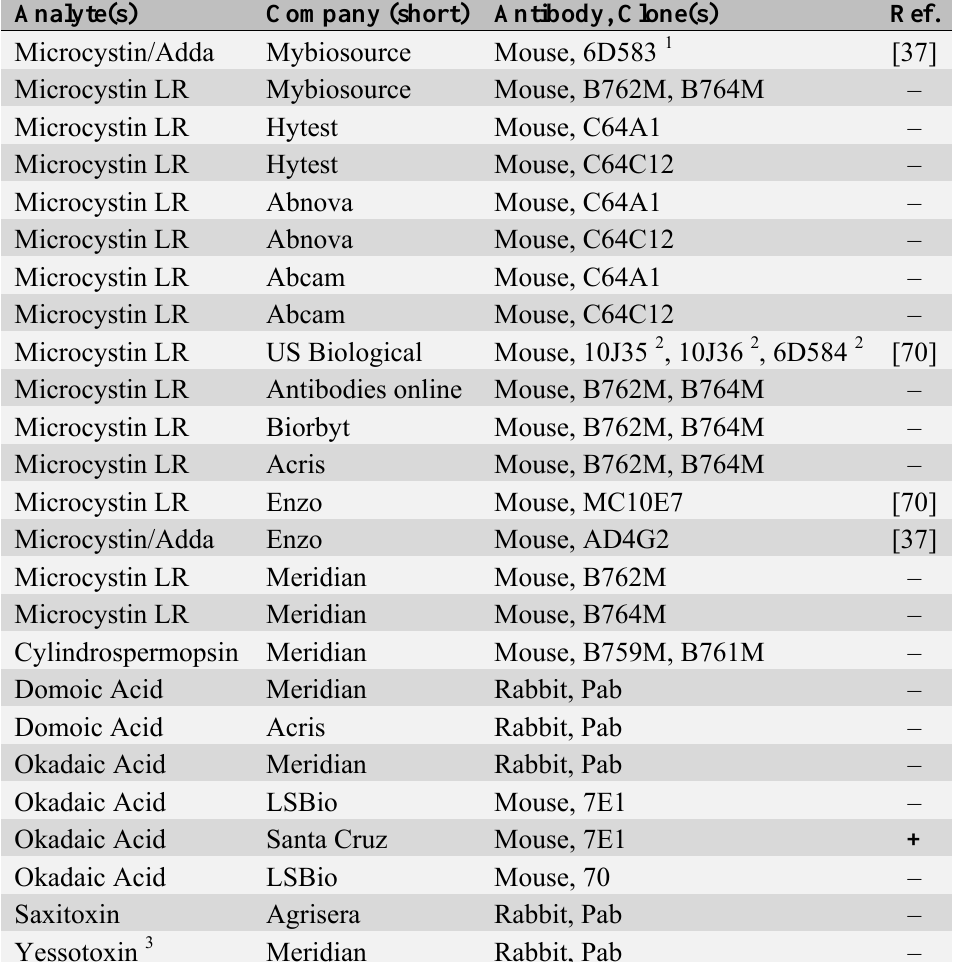
Table 3. Commercial antibodies against cyanobacterial and some marine toxins †